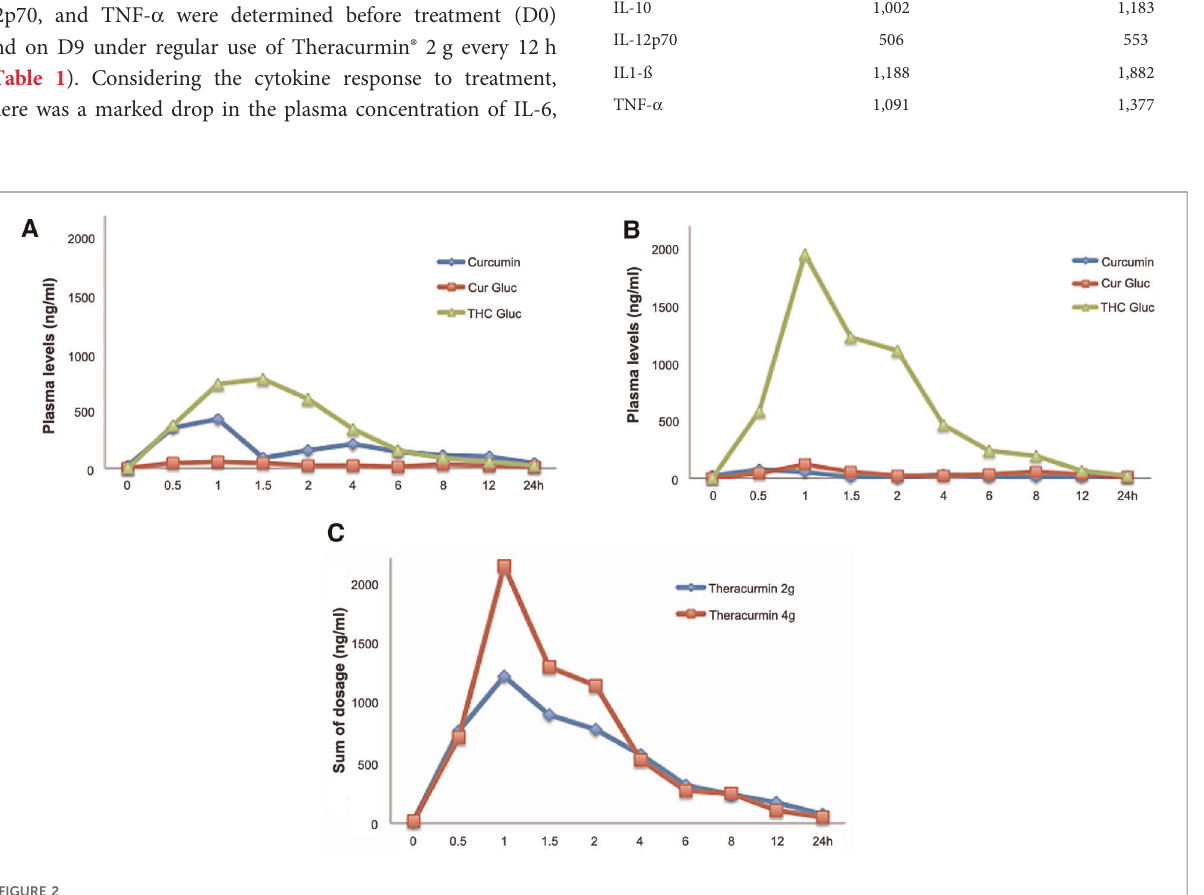
FIGURE 2 Curcumin and metabolites levels in patients ’ s plasma. ( A ) 2-g Theracurmin®; ( B ) 4-g Theracurmin®; ( C ) Sum comparison of all curcumin fractions and metabolites with 2-g and 4-g Theracurmin®. Cur Gluc: Curcumin Glucuronidase; THC Gluc: Tetrahydrocurcumin Glucorunidase.